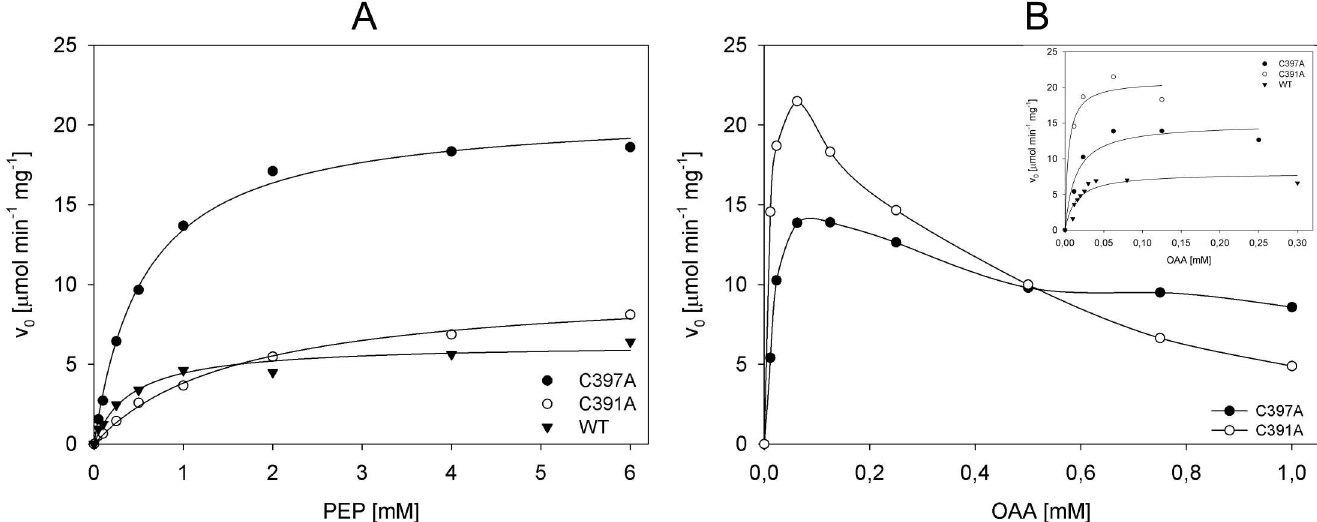
Fig 4. Substrate kinetics for C391A and C397A Pck mutants. (A) OAA synthesis via anapleroticreactionand (B) PEP synthesis via gluconeogenic reaction.